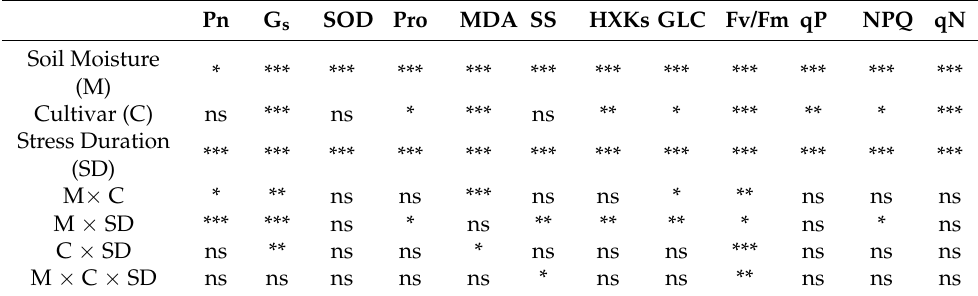
Table 2. Combined ANOVA for physiological and biochemical